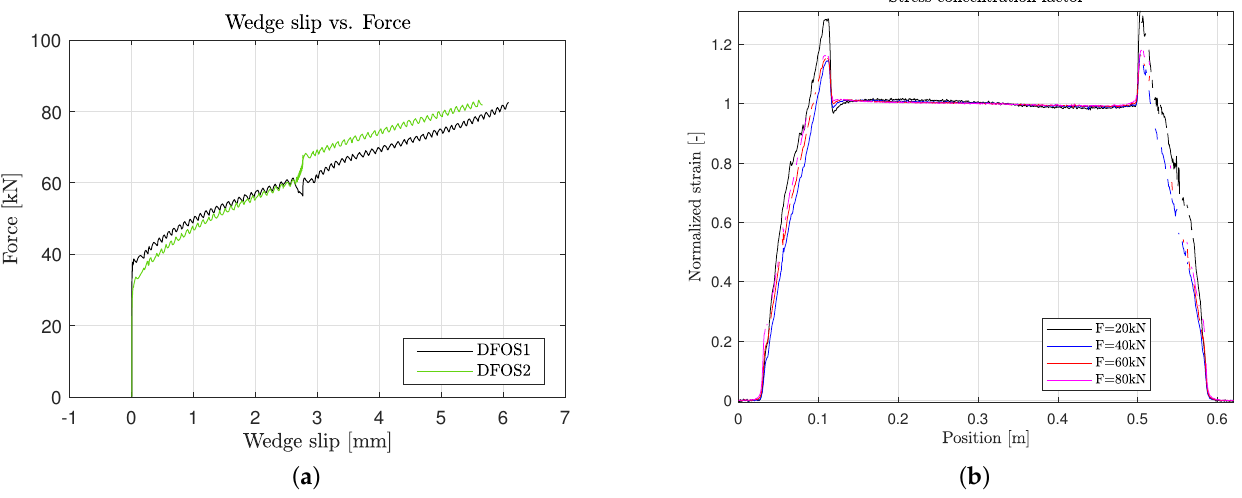
Figure 14. Wedge slip and stress concentration factor. ( a ) Wedge slip starting between 30 and 40 kN; ( b ) stress concentration at different